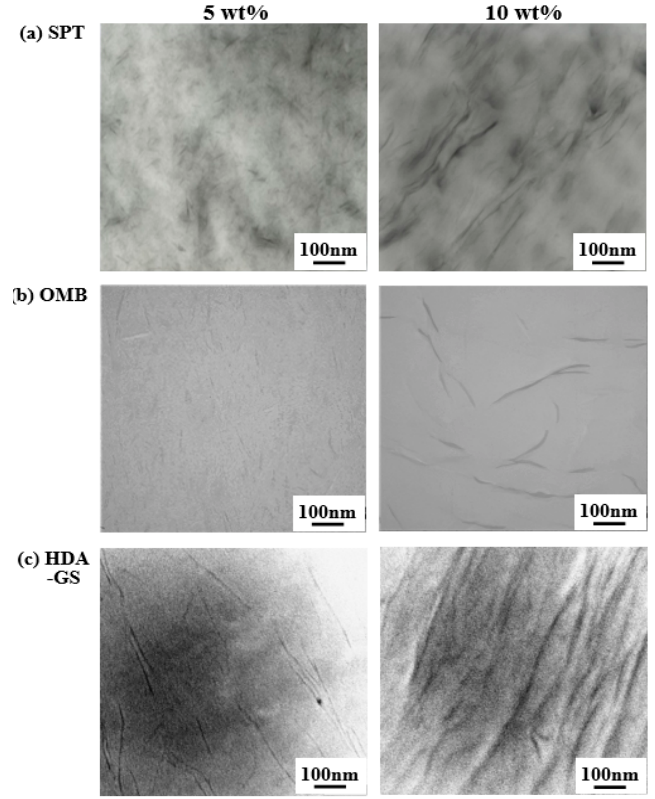
Figure 7. TEM micrographs of PVA hybrid films with different nanofiller contents: ( a ) SPT, ( b ) OMB, and ( c ) HDA-GS in PVA.